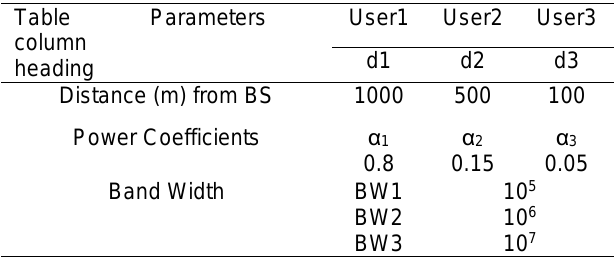
Table 1. Parameters utilized for the first scenario Table column heading